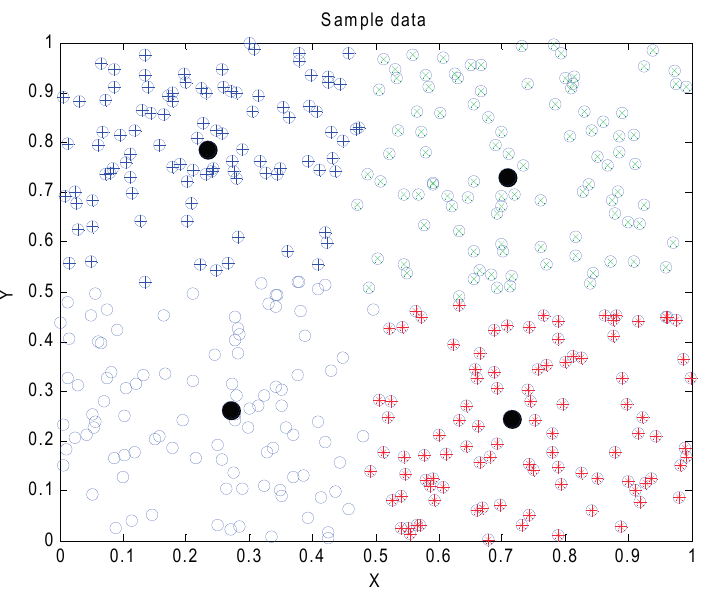
Figure 4. Clustering results of the KHE